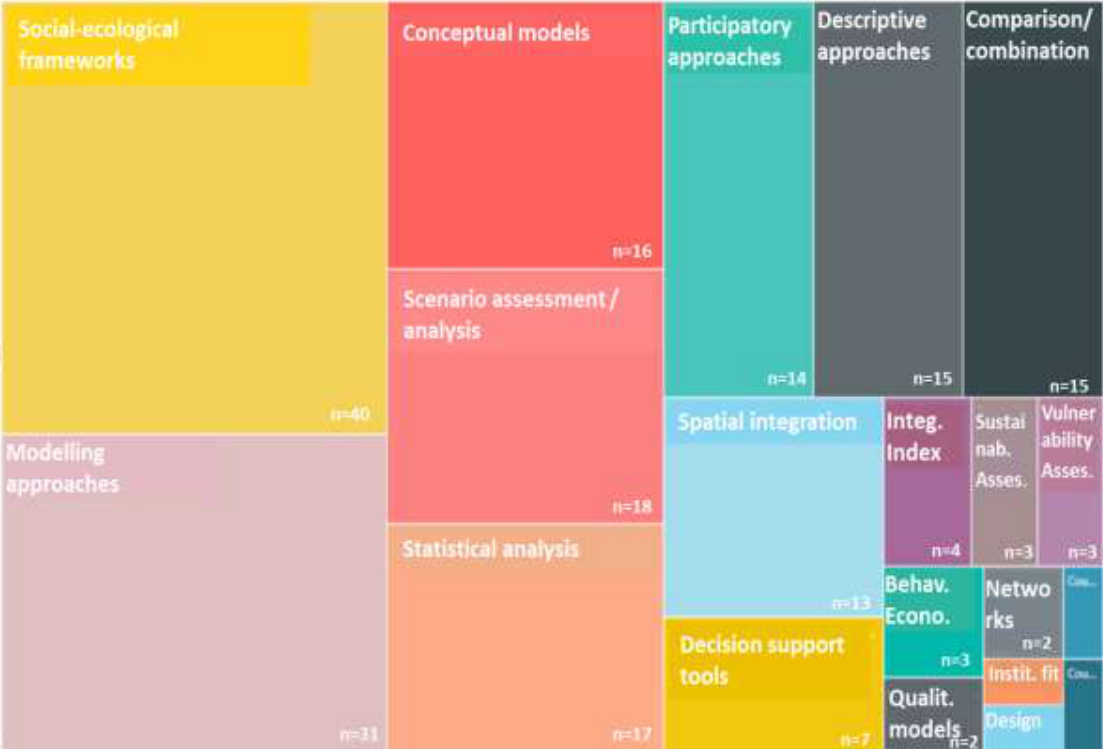
Fig. A4.3 Methods used in social-ecological research (n=110). Area of each quadrant denotes proportion. Each paper was assigned to one method or more. Institutional fit and telecoupling were found only once our sample. Social-ecological frameworks used include the Social-ecological Systems framework (n=9), the Resilience framework (n=11), the Ecosystem Services framework (n=9), the Driver-Pressure-State-Impact-Response framework (n=5), the Management Strategy Evaluation framework (n=2), the Sustainable Livelihoods framework (n=1; ref), and the Pressure- State-Response framework (n=1). Modelling approaches used include agent-based modelling (n=8), simulation modelling (n=8), dynamic modelling (n=7), system modelling (n=6), bio-economic modelling (n=5; ref), integrated modelling (n=4), bayesian belief networks (n=2), and game theoretic modelling